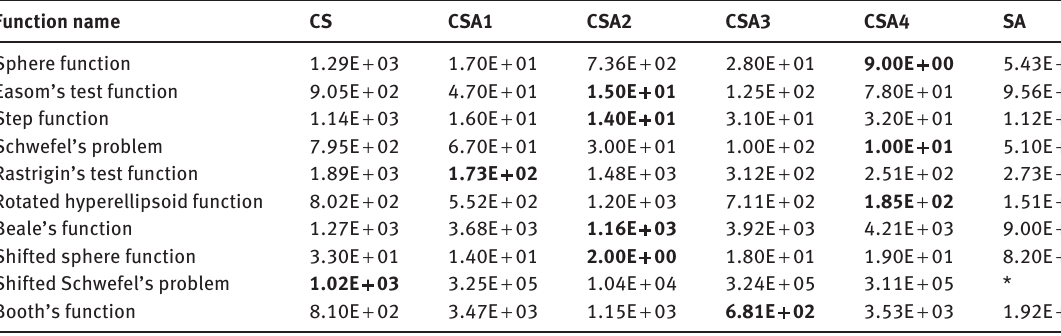
Table 7: Comparison of the Running Time of all the Variations of CSA to the Running Time of CS and SA based on the Conver- gence to the Best Value of